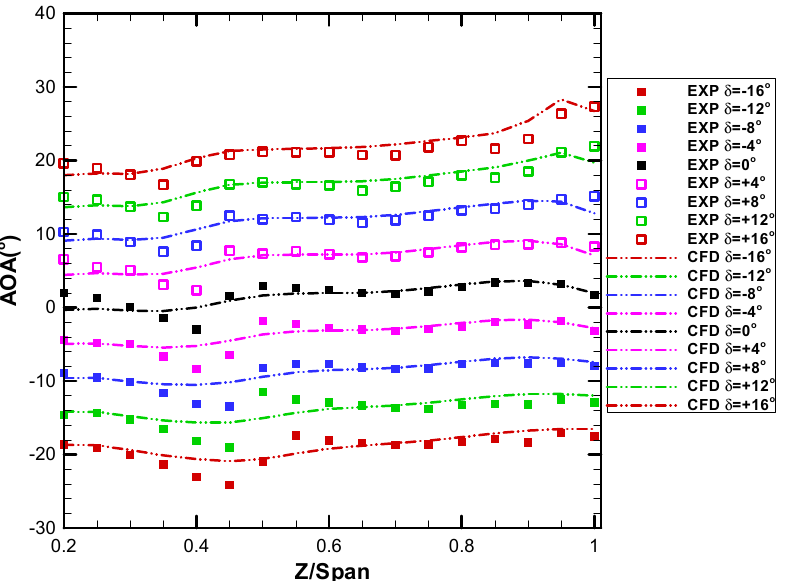
Figure 24. Comparison of angle-of-attack distribution in asymmetry-type rudder inflow (STB side, symbol: experiment, dotted line: numerical simulation).